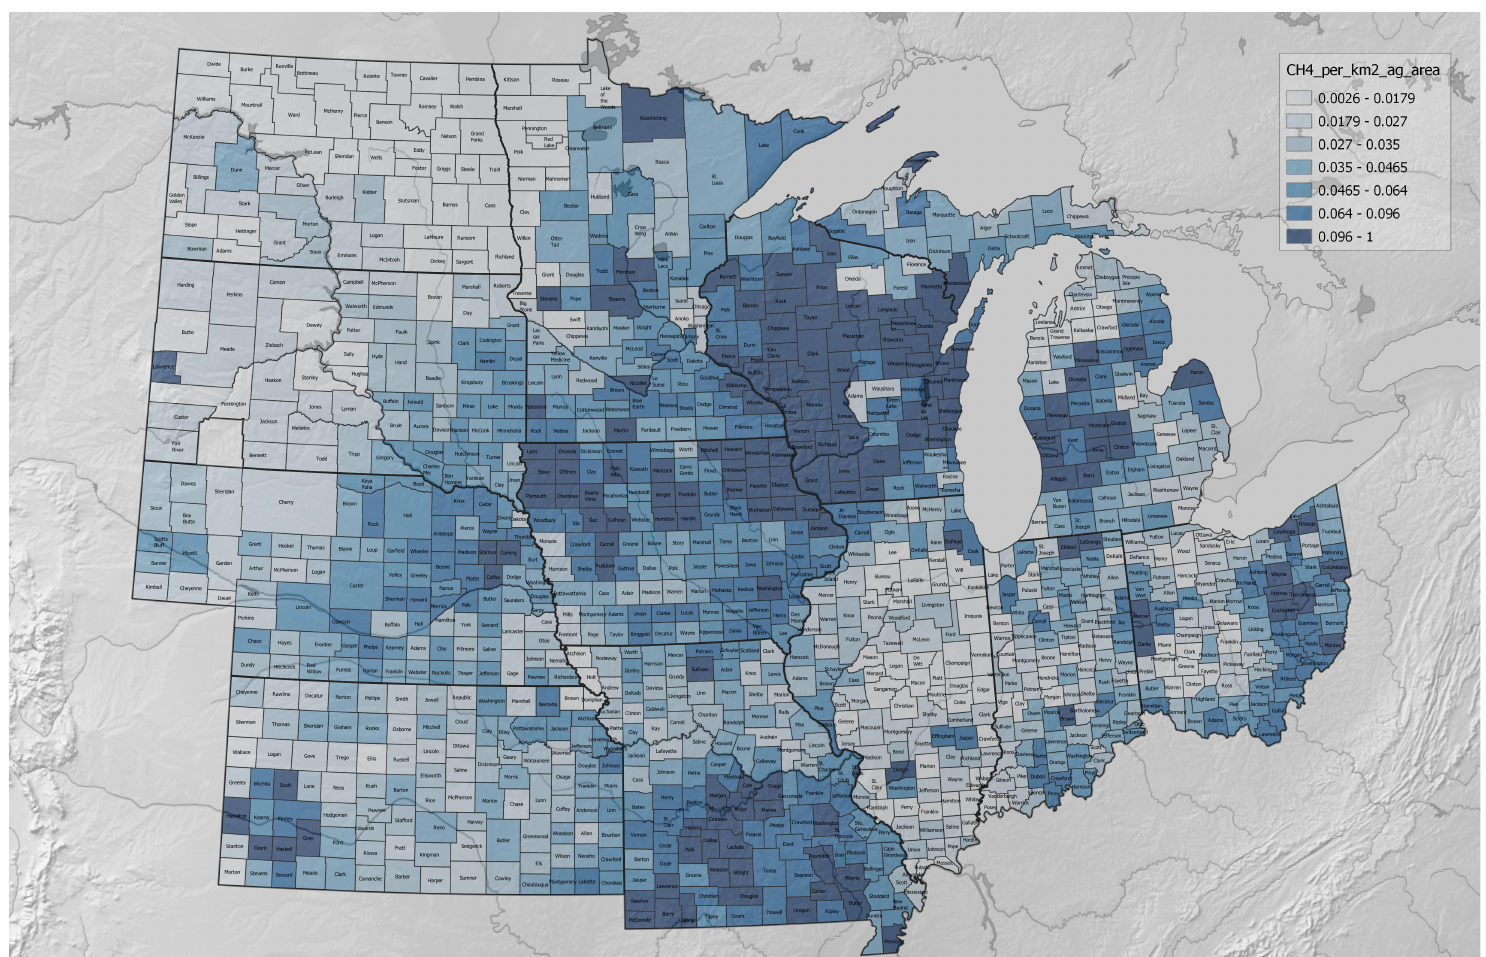
Figure A13. Agricultural methane emissions per square kilometer, by county, 2012. Values were all rescaled through dividing by the largest value present for any of the counties included here (0.114 moles CH 4 per second per square kilometer in St. Louis County, Missouri), as this transformation was applied to the variable data as they were placed into the index expression. Methods for CH4_per_km2_ag_area are described in the article main text and Supplementary Materials. Data from [67] were